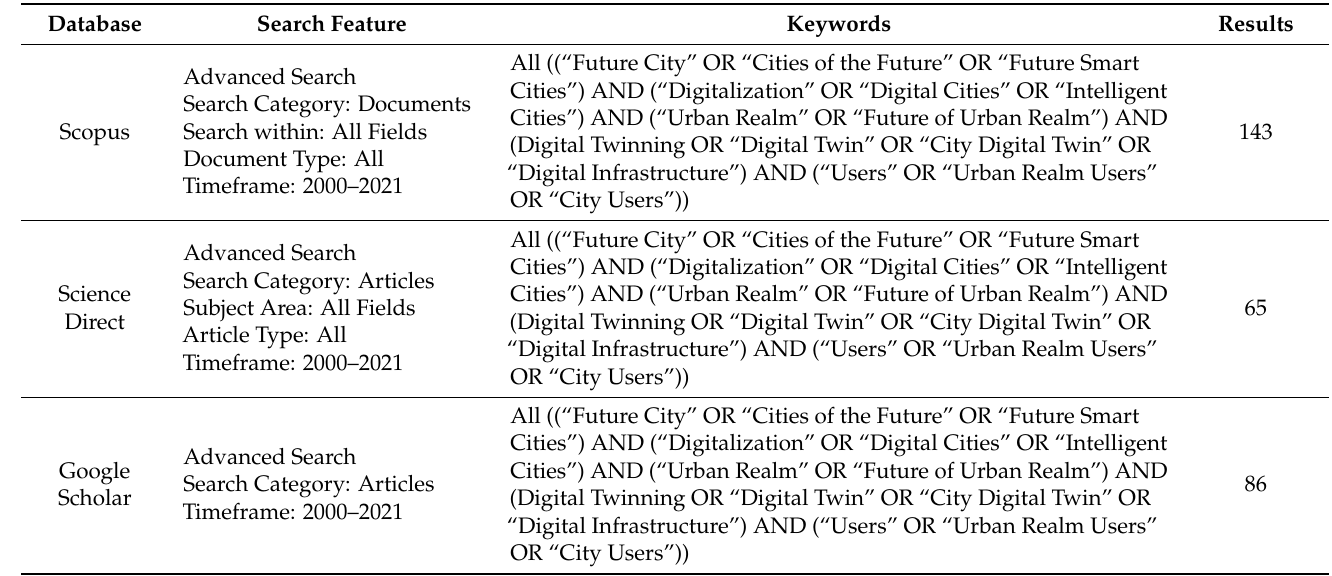
Table 1. Literature Identification Search.